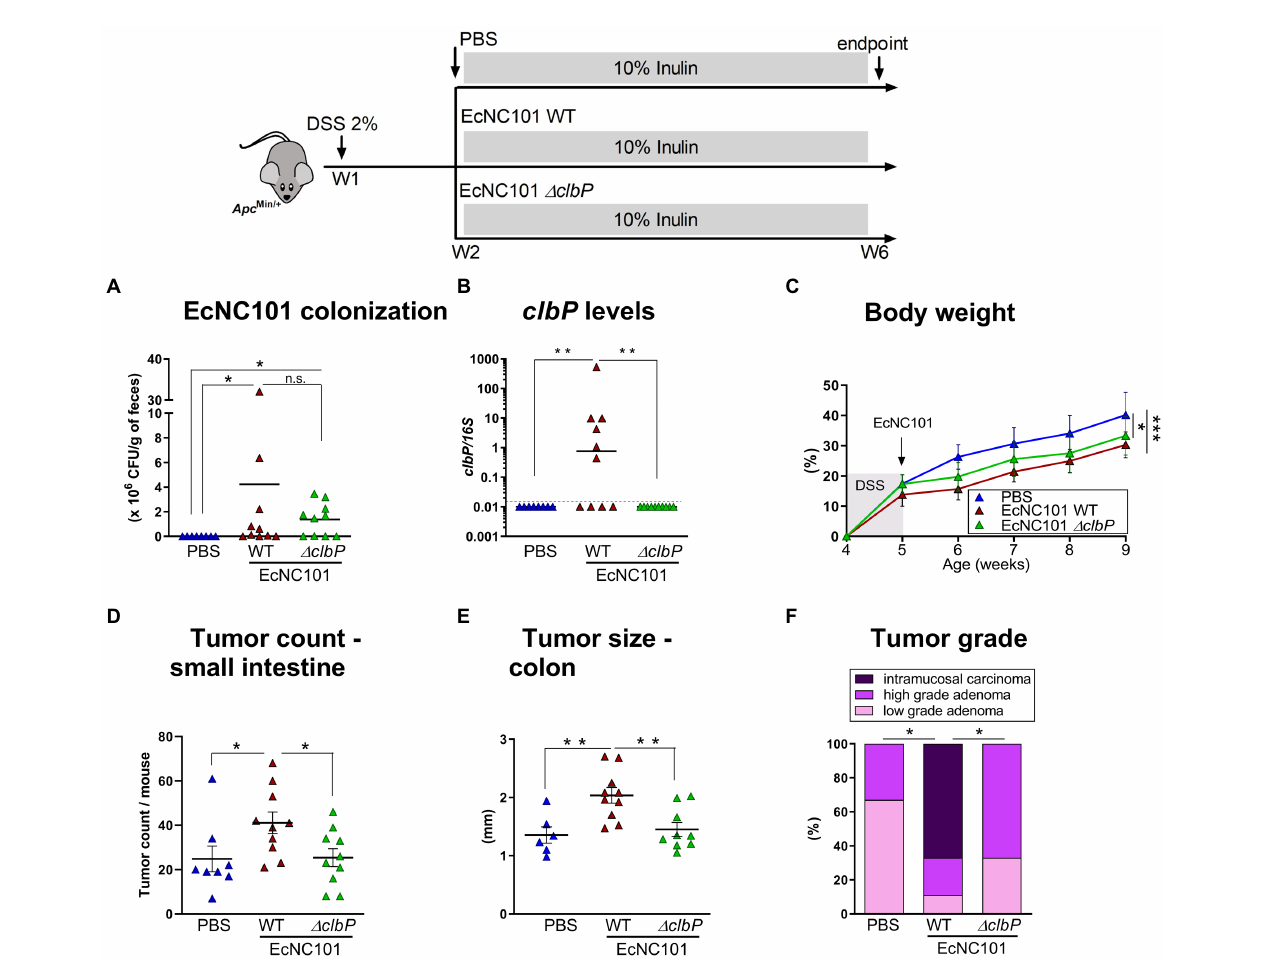
FIGURE 2 Tumorigenesis in Apc Min/+ mice fed inulin and colonized with wild-type and colibactin-deficient EcN101 strains. (A) EcNC101 colonization assessed by CFUs and (B) colibactin P gene by qPCR in fecal samples. (C) Body weight (mean ± SEM; repeated-measure ANOVA). (D) Tumor count in the small intestine. (E) Tumor size in the colon. (F) Colonic tumor grades (Chi-square Test). n.s. non-significant; * p < 0.05, ** p < 0.01. ANOVA, N = 8–11 per